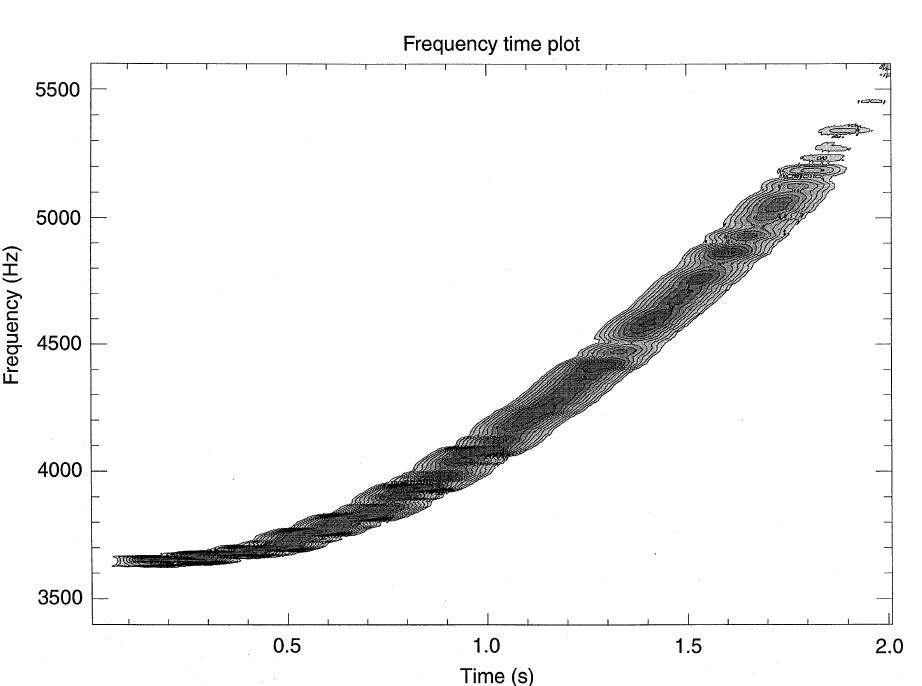
Fig. 5. Case A. Riser. Frequency time plot of the exit wavefield, shown as a shaded IDL contour plot . A key-down weak CW input signal of 0.1 pT gives a long stable rising emission with a sweep rate of